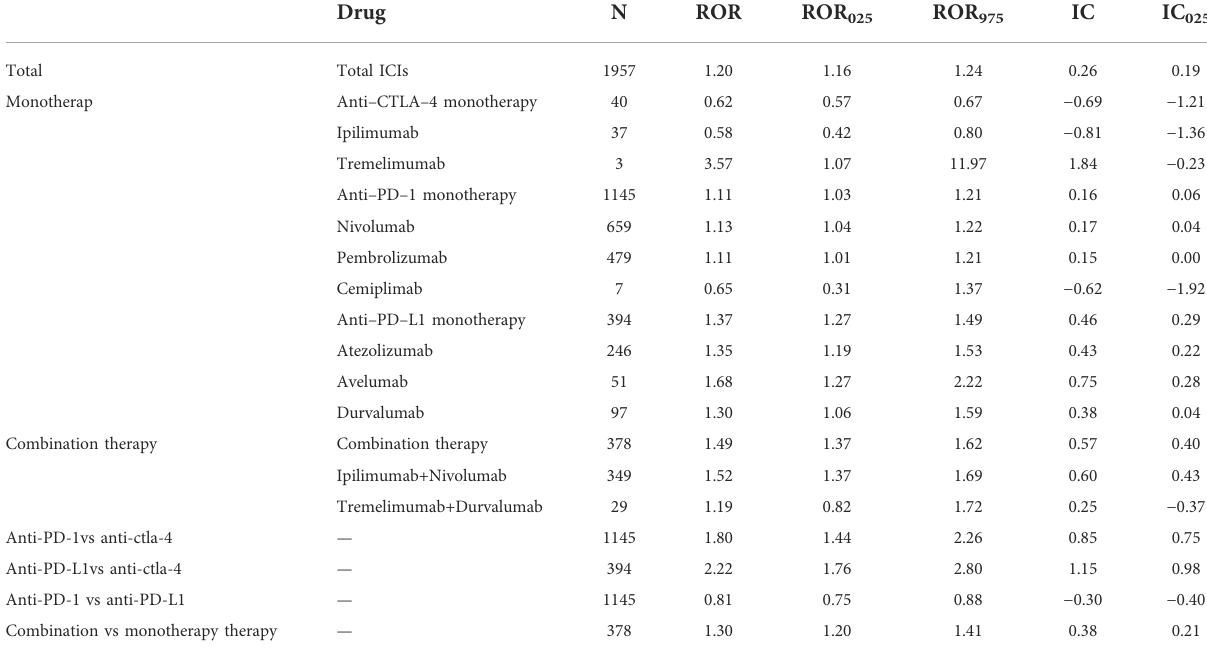
TABLE 2 Associations of different ICI regimens with cardiac